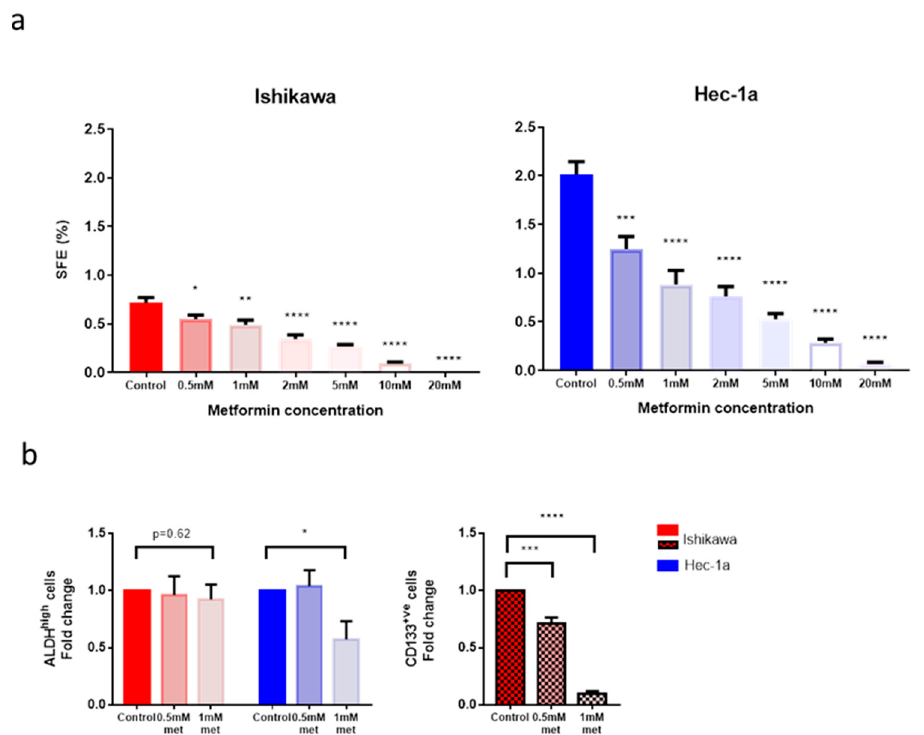
Figure 3. E ff ect of metformin on endometrial cancer stem cell number and activity. ( a ) On the left, SFE of Ishikawa cells treated with metformin in non-adherent culture. On the right, SFE of Hec-1a cells treated with metformin ( n = 3). ( b ) On the left, the proportion of ALDH high cells following treatment of Ishikawa and Hec-1a cells with metformin. On the right, the proportion of CD133 + ve Ishikawa cells following treatment with metformin ( n = 5). Data are represented as mean ± SEM. * p ≤ 0.05, ** p ≤ 0.01, ** p ≤ 0.001, **** p ≤ 0.0001.